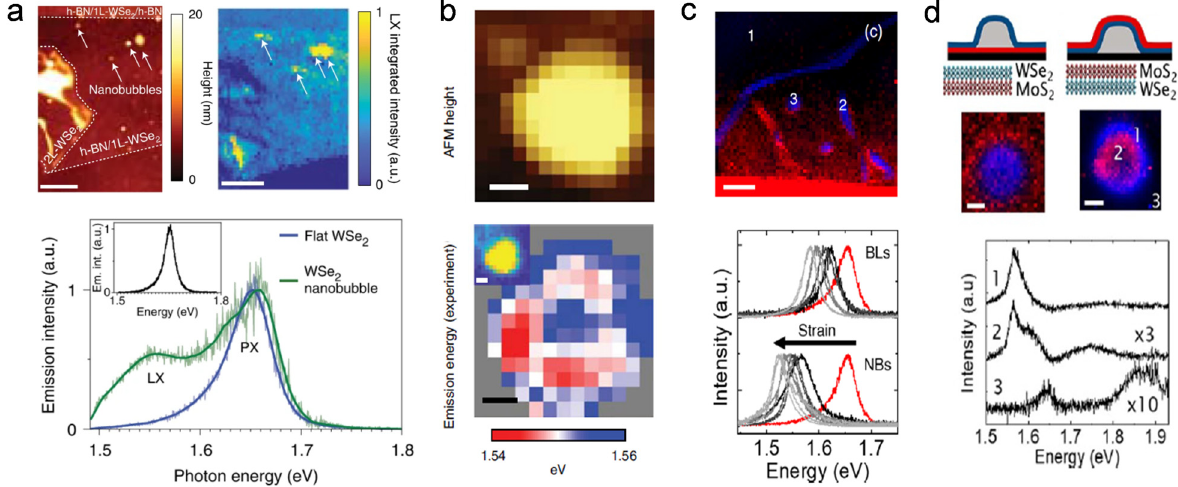
Figure 9: Near-field images of bubbles in 2D-TMDs. (a) Upper panel: AFM and TEPL images of 1L-WSe 2 . Lower panel: representative TEPL spectra obtained at fl at (blue) and nanobubble (green) regions. Inset: far- fi eld spectrum of 1L-WSe 2 . (b) AFM (upper panel) and TEPL peak energy (lower panel) images of a nanobubble. Reproduced with permission from ref. [119]. Copyright 2020, Nature Publishing Group. (c) Upper panel: TEPL image includes fl at (#1), blister (#2),